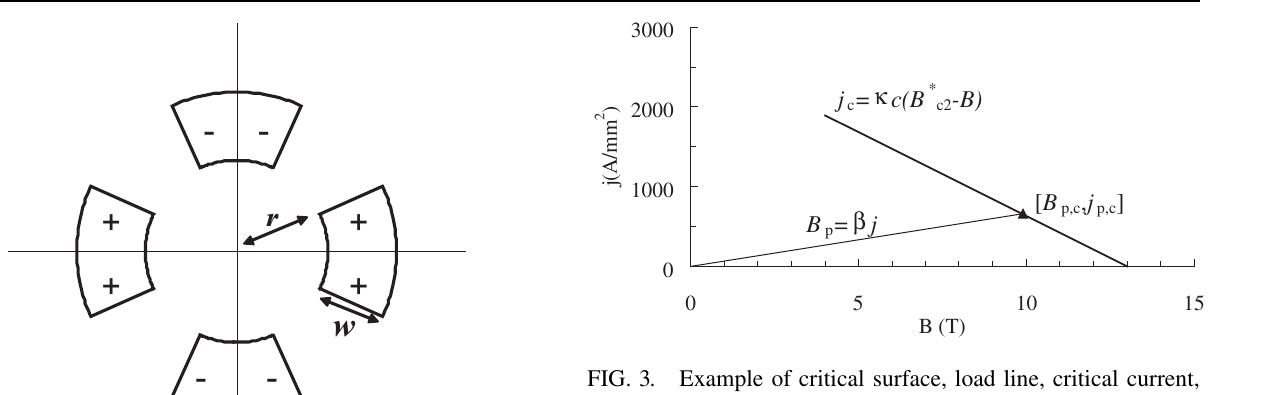
FIG. 3. Example of critical surface, load line, critical current, and critical peak field for the LHC main quadrupole (1.9